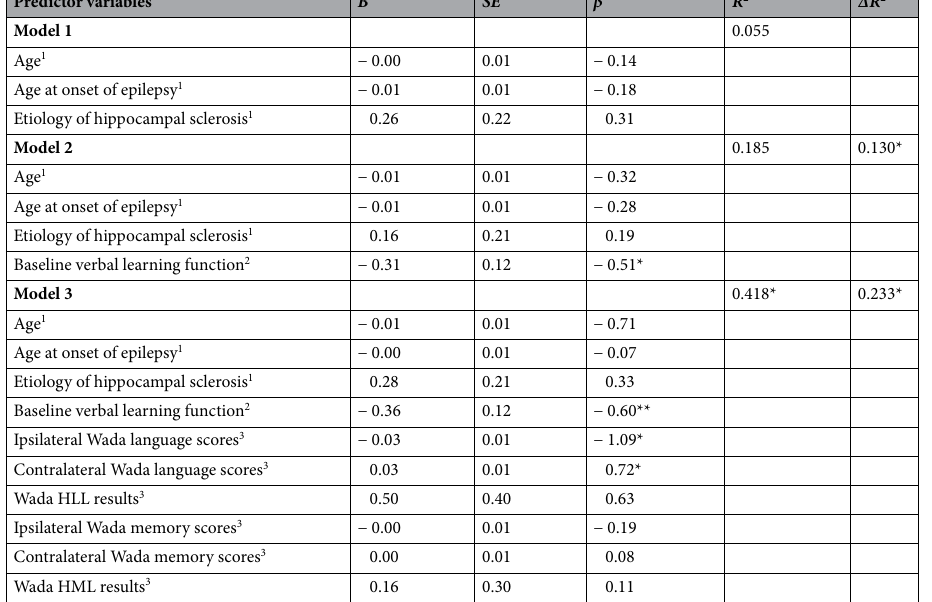
Table 4. Results of the hierarchical linear regression analysis for the prediction of postsurgical change in verbal learning function. Predictor variables entered the regression models in the first 1 , second 2 , and third 3 block. B , unstandardized coefficient; SE , standard error; β , standardized coefficient; HLL, hemispheric language lateralization; HML, hemispheric memory lateralization, * p < .05; ** p < .01. Etiology of hippocampal sclerosis categorized as 1 = present; 0 = absent. Wada HLL results categorized as 1 = surgery within the language- dominant hemisphere; 0 = surgery within the non-dominant hemisphere. Wada HML results categorized as 1 = surgery within the memory-dominant hemisphere; 0 = surgery within the non-dominant